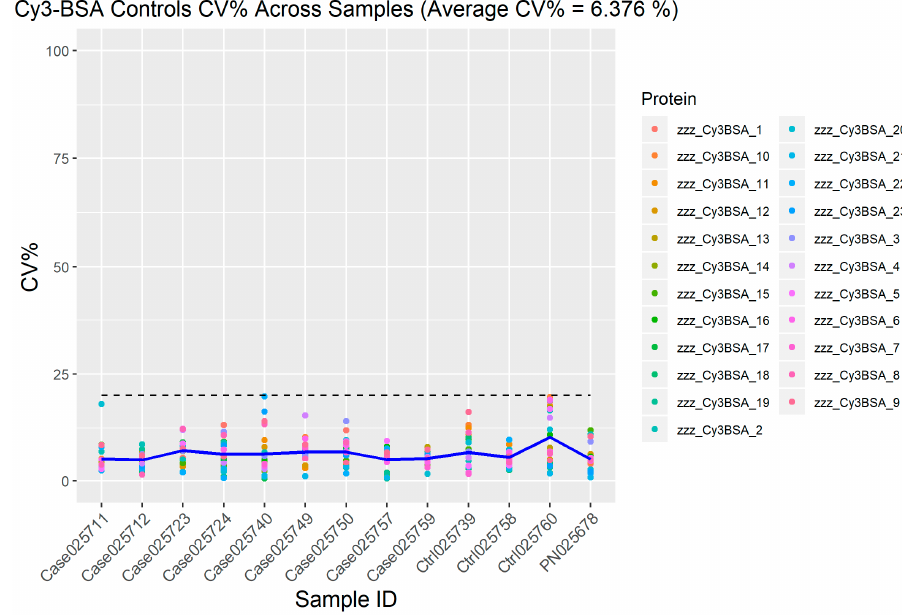
Figure 5. Intra-protein, intra-slide and inter-array CV% of six IgG replica spots across all samples. The relative fluorescence unit (RFU) mean CV% for all Cy3-BSA replicates across all samples was 6.376%; was below the cut-off points which was 15%. Blue line represents the mean CV% for each sample.